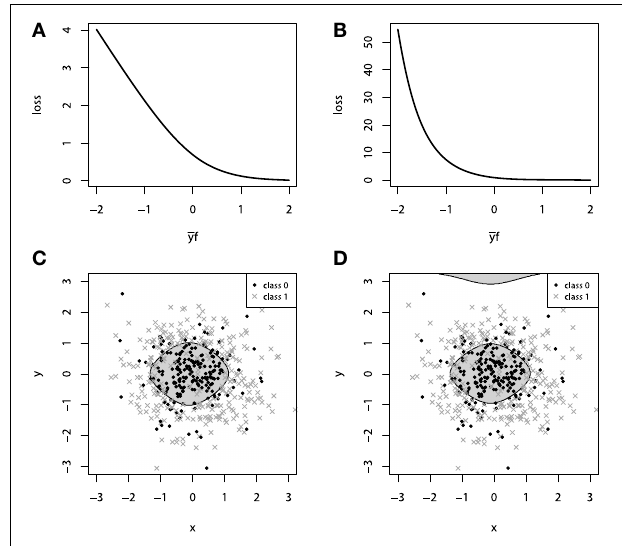
FIGURE 2 | (A) Bernoulli loss function. (B) Adaboost loss function. (C) GBM 2d classification with Bernoulli loss. (D) GBM 2d classification with Adaboost